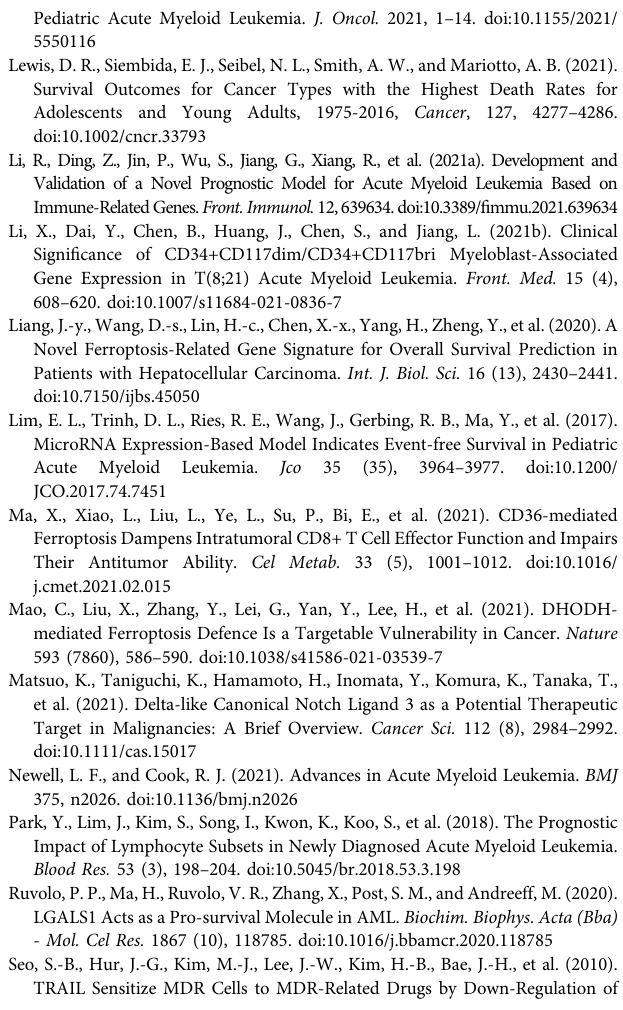
Supplementary Figure 1 | Functional enrichment analyses of the DEGs between two subtypes. (A) Enrichment results of GO molecular function containing Ferroptosis-related genes. (B) Enrichment results of GO biological processes containing Ferroptosis-related genes. (C) Enrichment results of GO cellular components containing Ferroptosis-related genes. (D) Enrichment results of KEGG pathway. Supplementary Figure 2 | Top 3 prognostic DEGs with the most signi fi cant p -value. (A – C) Gene expression (ITGAX, LGALS1, MIR551A) between the two subtypes and KM survival curves based on the high and low expression of them. ****represents p < 0.0001. Supplementary Table 1 | Analysis results of GO BP. Supplementary Table 2 | Analysis results of GO MF. Supplementary Table 3 | Analysis results of GO CC. Supplementary Table 4 | Analysis results of KEGG. Supplementary Table 5 | Analysis results of univariate Cox